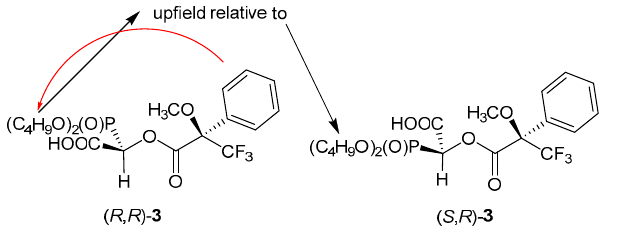
Figure 3. Anisotropic effect of phenyl group on hydrogen atoms of butyl groups.